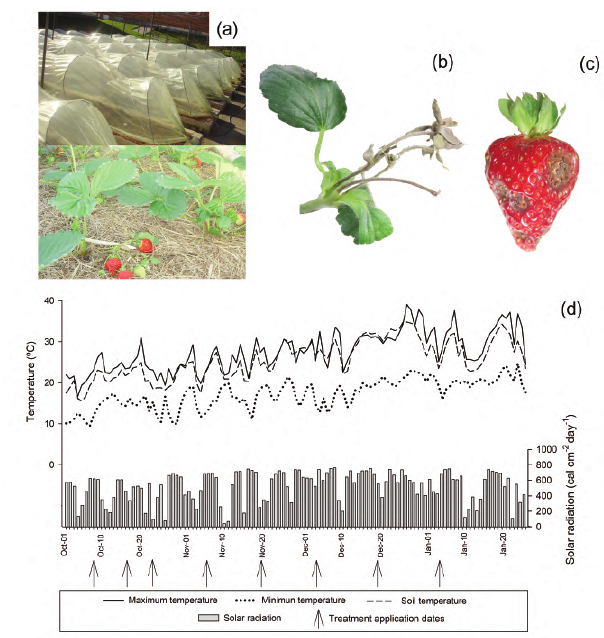
Fig. 1 ­ Experiment under field conditions (a), anthracnose symptoms in strawberry plants (b) and fruits (c), and cli­ matic data from the experiment period (d).